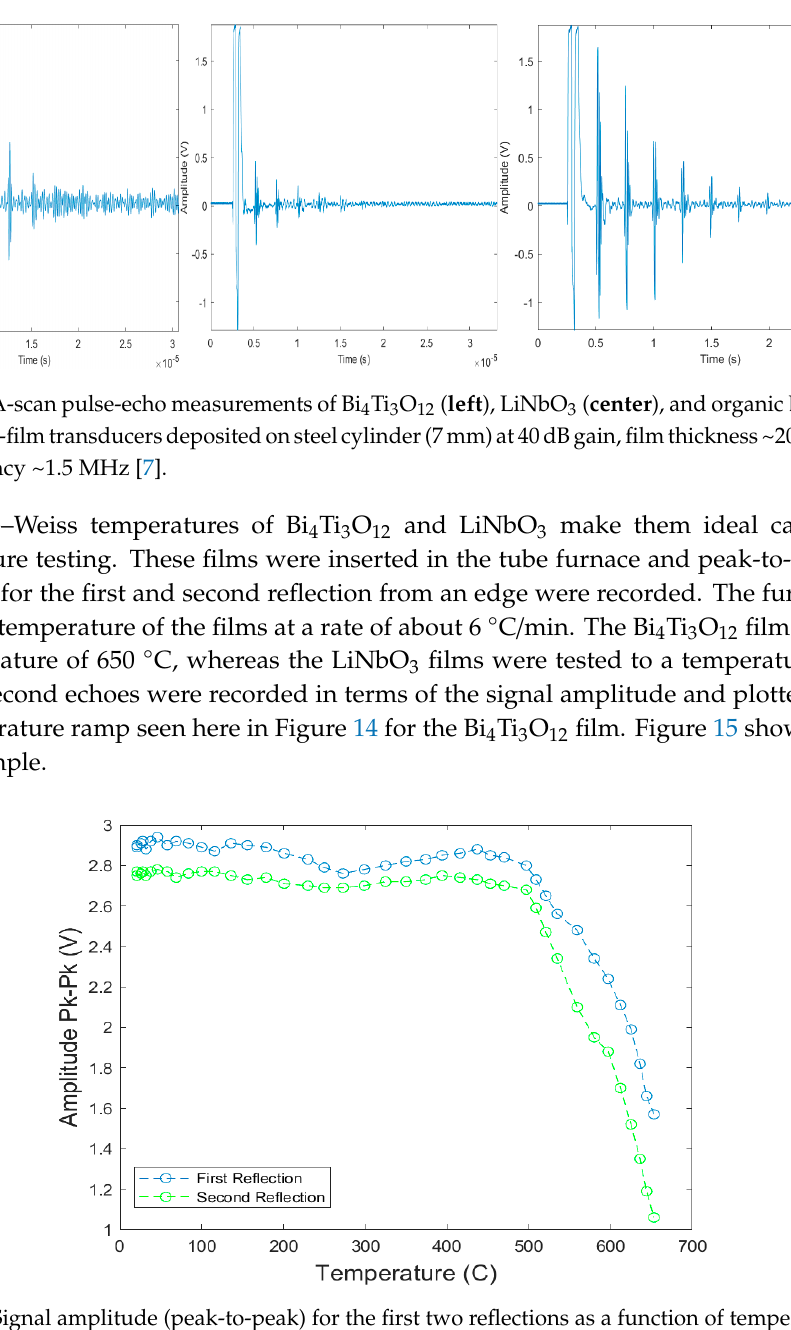
Figure 15. Signal amplitude (peak-to-peak) for the first two reflection as a function of the temperature for lithium niobate thick-film, spray-on transducer [7]. To demonstrate their ability to perform as a guided-wave sensor, the primary Lamb wave modes (A0, S0, A1, S1) were generated using a comb transducer arrangement. Furthermore, 6061 aluminum plates of several different thicknesses ranging from 2 to 4 mm were chosen as the waveguides. Sets of comb transducers were then applied onto the plate a certain distance apart in a through- transmission setup as shown in Figure 16a,b.